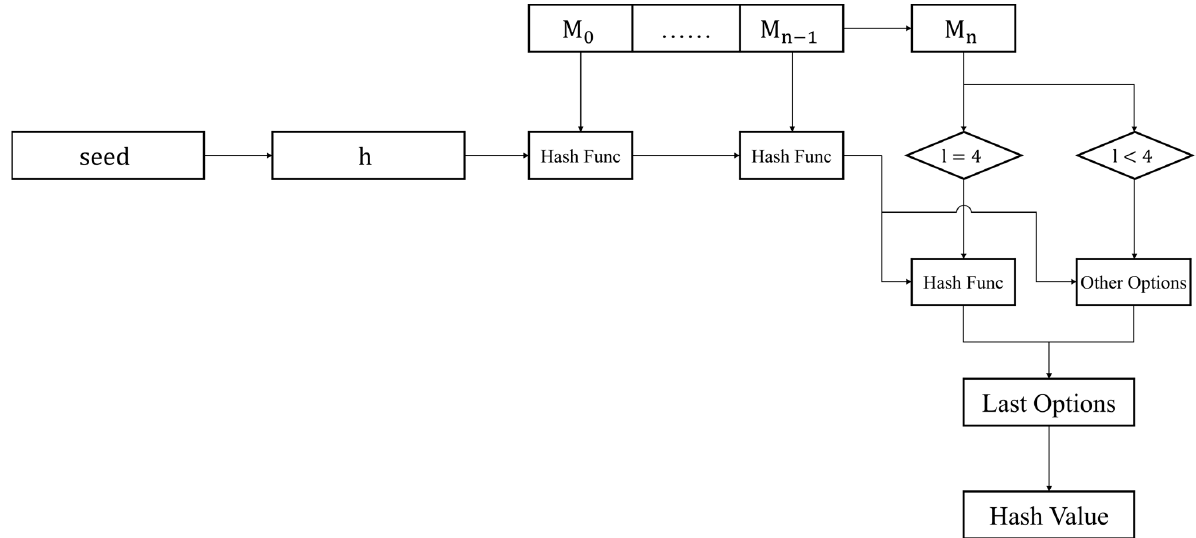
Figure 4. MurMurHash.